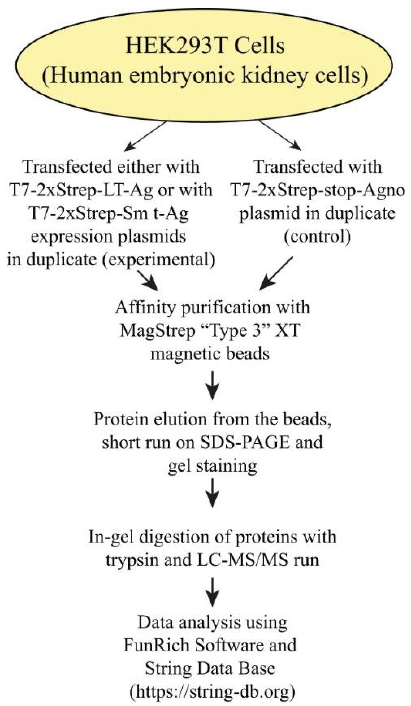
Figure 2. A graphical presentation of the experimental design to determine the JCV LT-Ag- and JCV Sm t-Ag-interacting proteins by affinity purification/mass spectroscopy analysis (AP/MS).